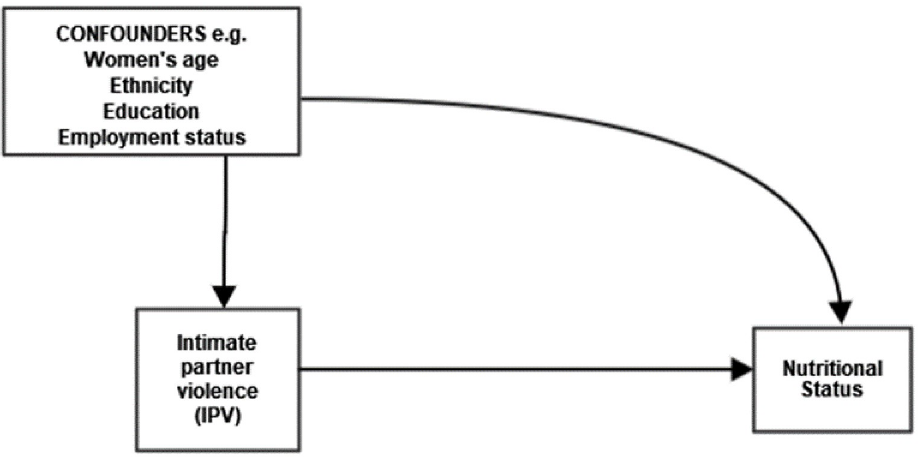
Fig 1. Directed acyclic graph for the current